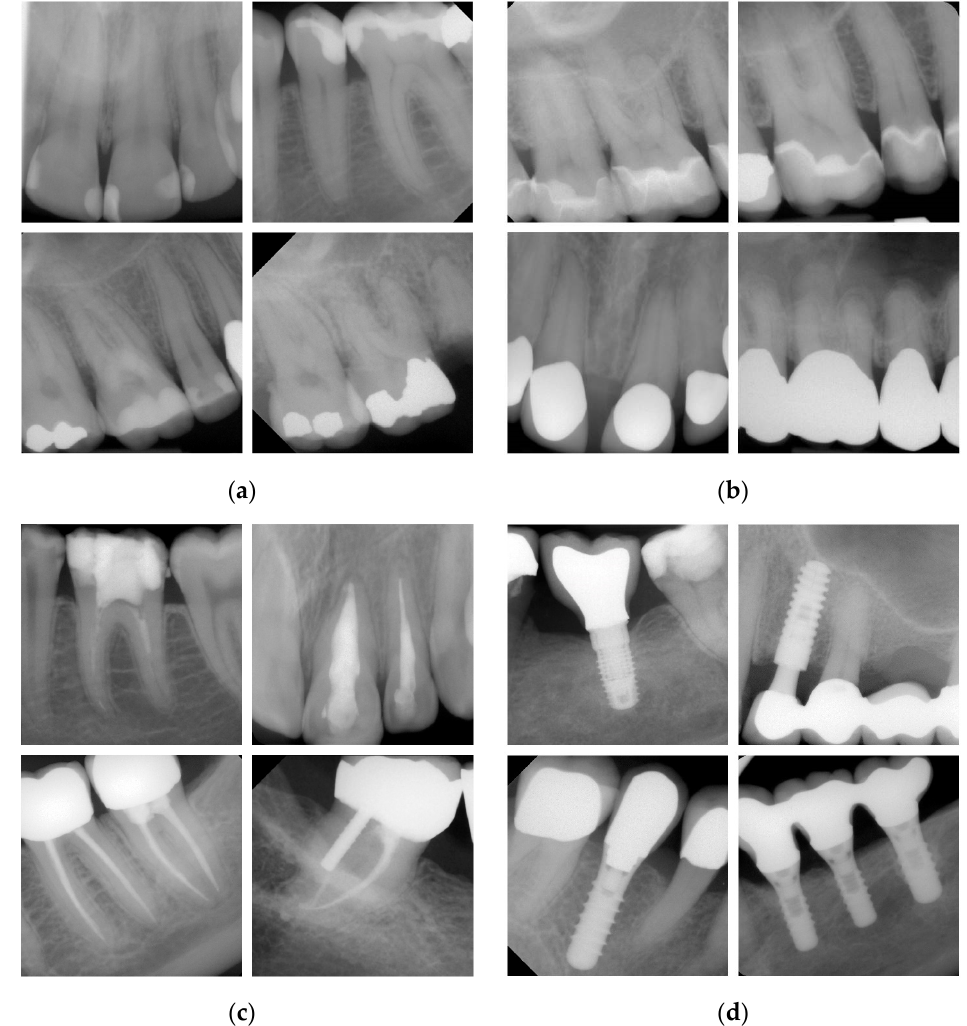
Figure 1. Representative examples of periapical radiographs for the evaluated diagnostic categories: ( a ) directly applied composite or amalgam restorations; ( b ) various types of indirectly manufactured ceramic, porcelain-fused to metal or metal crowns; ( c ) different types of temporary and definitive root canal fillings; ( d ) typical dental implants from divergent manufactures.